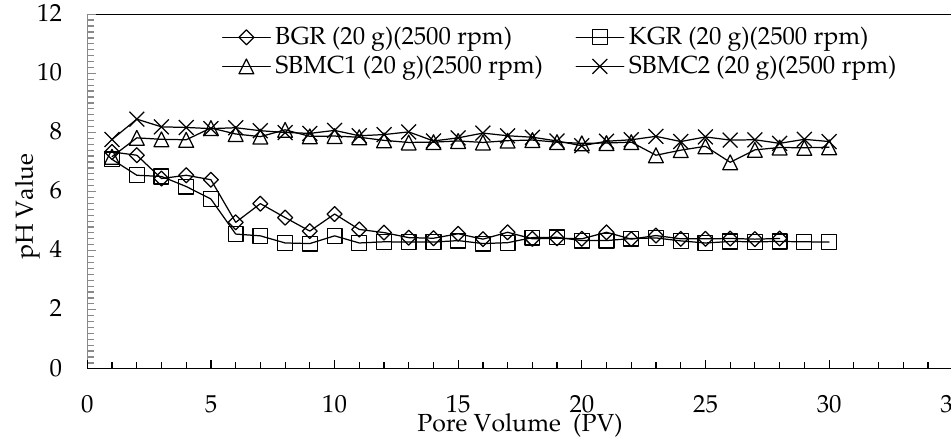
Figure 9. Soil buffering capacity of granitic residual soil and marine clay.